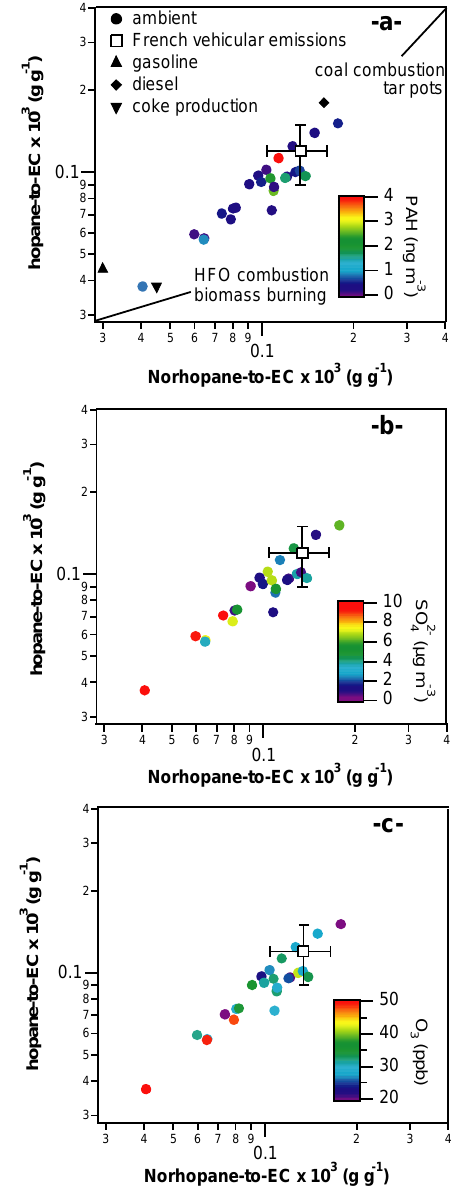
Fig. 10 Fig. 10. Ratio-ratio plot of 17 α (H)-21 β (H)-norhopane and 17 α (H)- 21 β (H)-hopane normalized by EC for the ambient data in Marseille. Colours of ambient data scatter plot denote the concentration lev- els of (a) PAH (sum of: benzo[b,k]fluoranthene, benzo[e]pyrene, indeno[1,2,3-cd]pyrene and benzo[ghi]perylene) (ng m − 3 ) , (b) in- organic sulfate (µgm − 3 ) and (c) ozone (ppb). Also shown are emission ratios for different sources of hopanes and EC, including: French vehicular emissions (El Haddad et al., 2009), gasoline cata- lyst vehicles (Schauer et al., 2002), diesel vehicles (Schauer et al., 1999), coke production (Weitkamp et al., 2005), coal combustion (Oros and Simoneit, 2000; Zhang et al., 2008), tar pots (Rogge et al., 1997a), and HFO combustion (Rogge et al., 1997b). Arrows point to sources that do not fall within the bounds of the